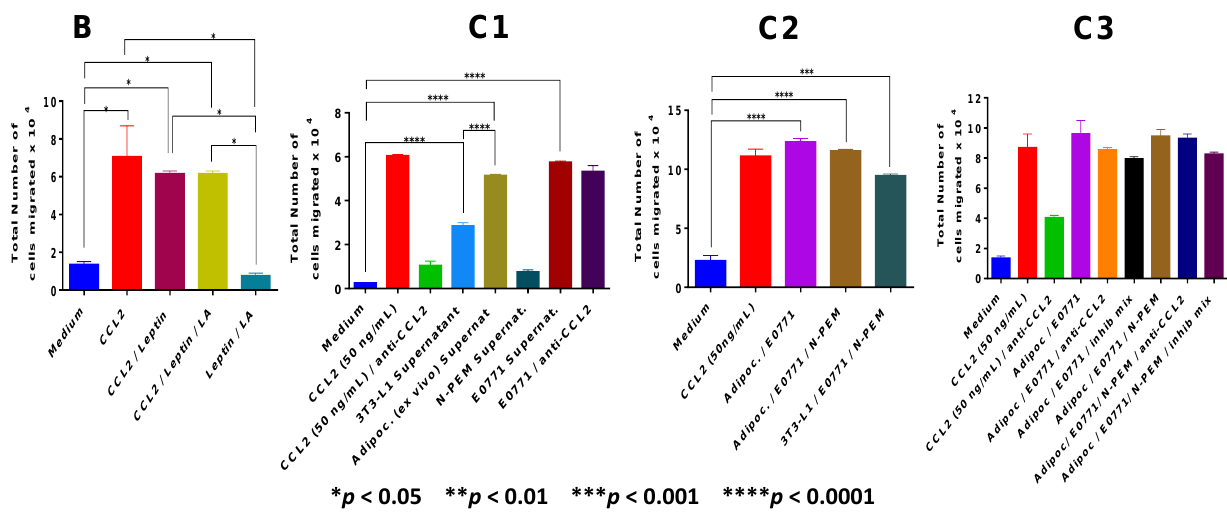
Figure 4. Migration studies with human monocytic cell line THP1. Chemotaxis experiments were conducted for 2.5 h at 37 °C. Top Chamber (ThinCert 8 µm pores): 1 × 10 6 THP1cells in 100 µL vol. Bottom chamber contained the chemoattractant cells supernatants or recombinant/synthetic factors in 600 µL volume. ( A1 ) CCL2 is a major monocyte chemoattractant, anti-CCL2 antibody (25 µg/mL) significantly reduces its activity. ( A2 ) Increasing leptin concentrations has weak and ns chemotactic activity. ( A3 ) Lauric